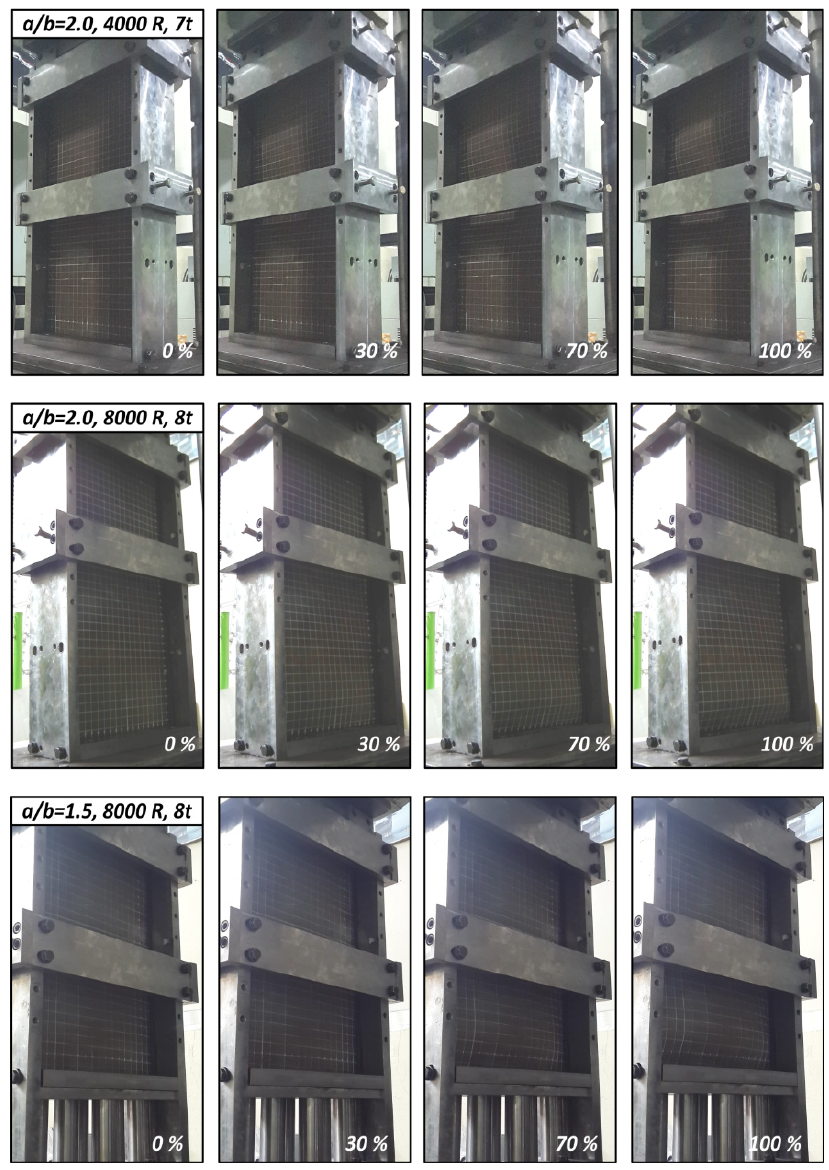
Figure 5. Buckling collapse test for curved plates.